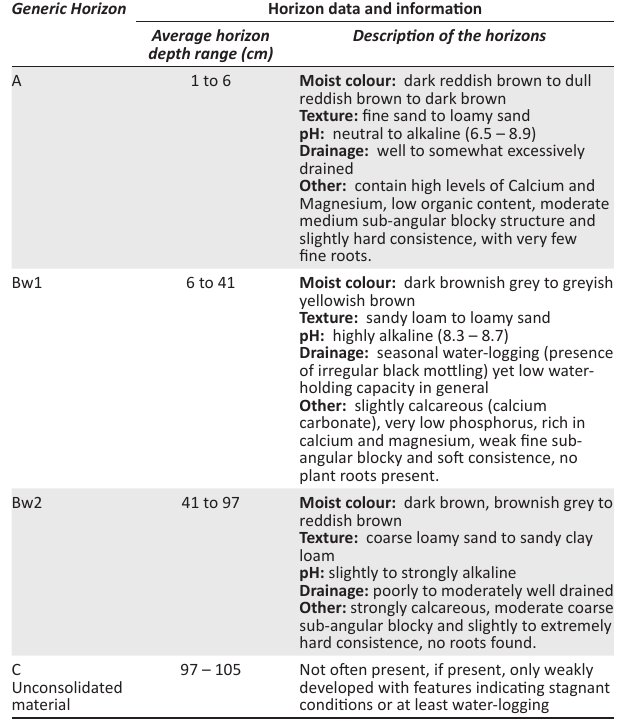
TABLE A1.2b: Differentiating characteristics of the calcaric